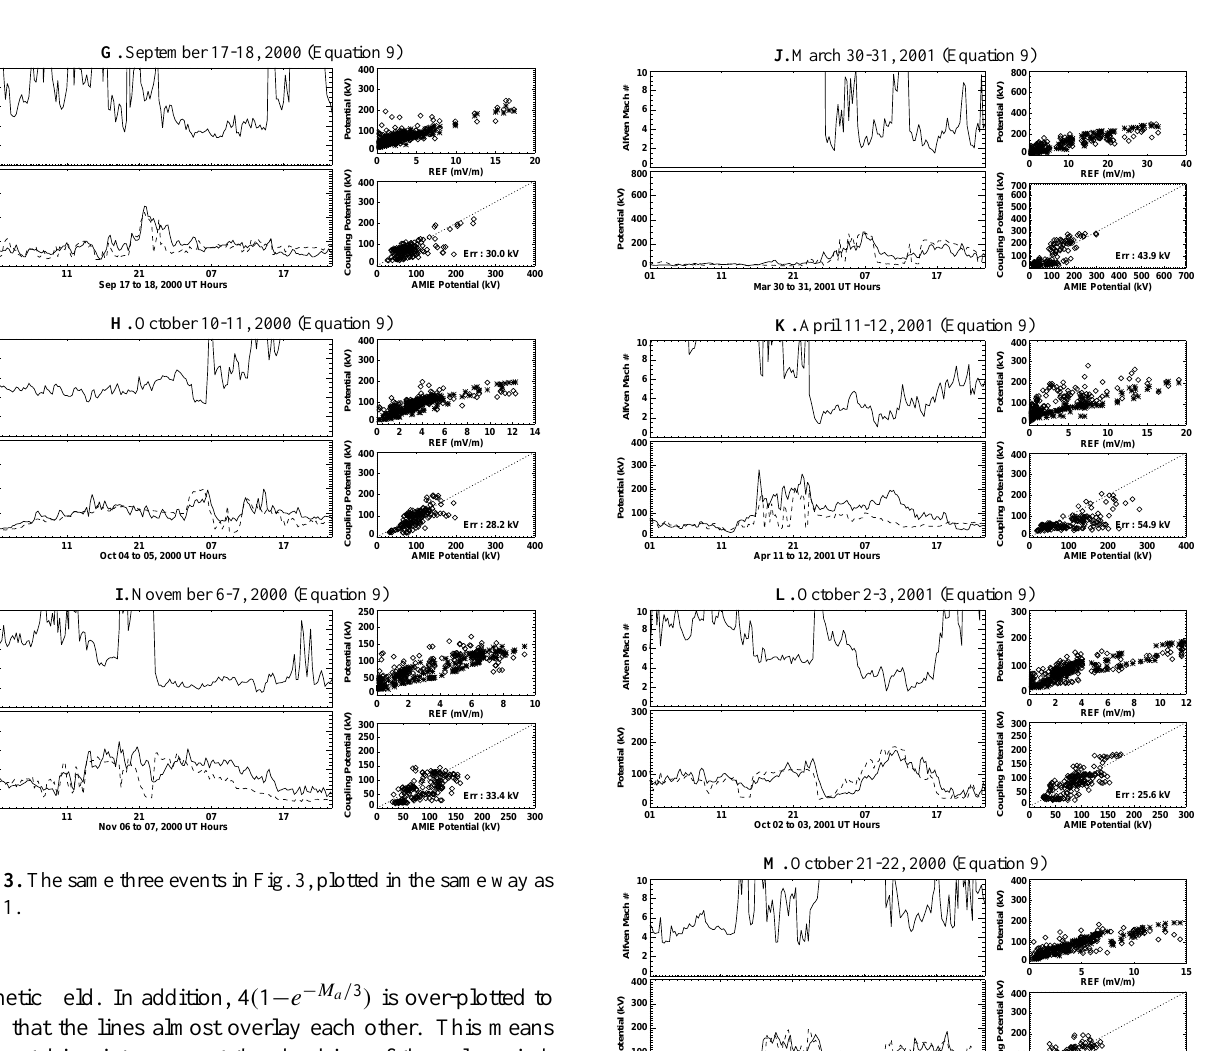
magnetic field. In addition, 4 ( 1 − e − M a / 3 ) is over-plotted to